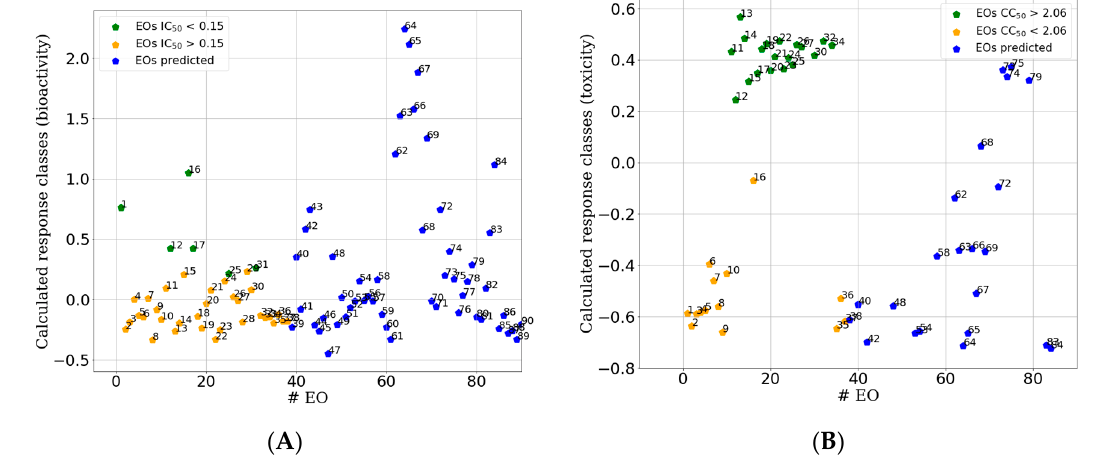
Figure 10. Sample plots for external test set (blue points) predicted by the IC 50 -PLS-DA classification ( A ) and by the CC 50 -PLS-DA classification. On the y-axis are reported the calculated response bioactivity classes ( A ) and toxicity class ( B ) by the PLS-DA model (X score × Y weights) [24] for all predicted EOs (test set, Table 2). For comparison in the plot are also reported the points relative to the training set (green and orange points, Figure 6). Table 5. Experimental results obtained from biological assays on the predicted samples (see text).